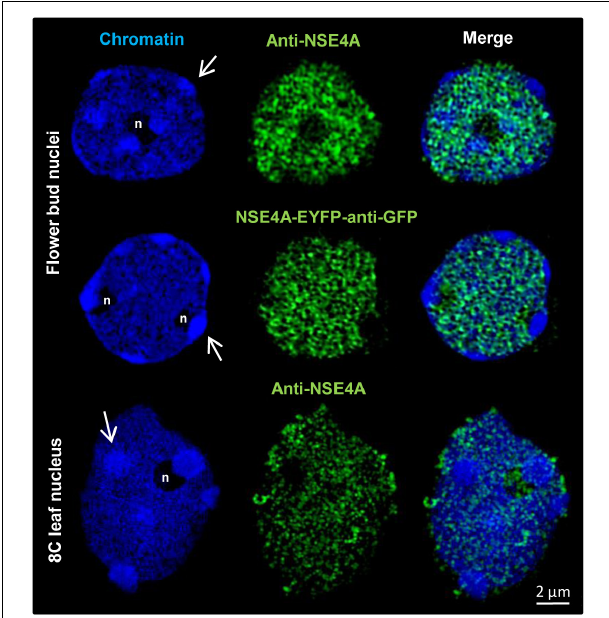
FIGURE 7 | The distribution of NSE4A in differentiated somatic flower bud and 8C leaf interphase nuclei analyzed by 3D-SIM. In agreement, both NSE4A antibodies (anti-NSE4A) and NSE4A-EYFP signals detected by anti-GFP antibodies indicate that NSE4A is distributed within euchromatin, but absent from heterochromatin (DAPI-intense chromocenters, arrows). The NSE4A labeling visible in the merged image of the 8C nucleolus (maximum intensity projection) originates from optical sections outside of the